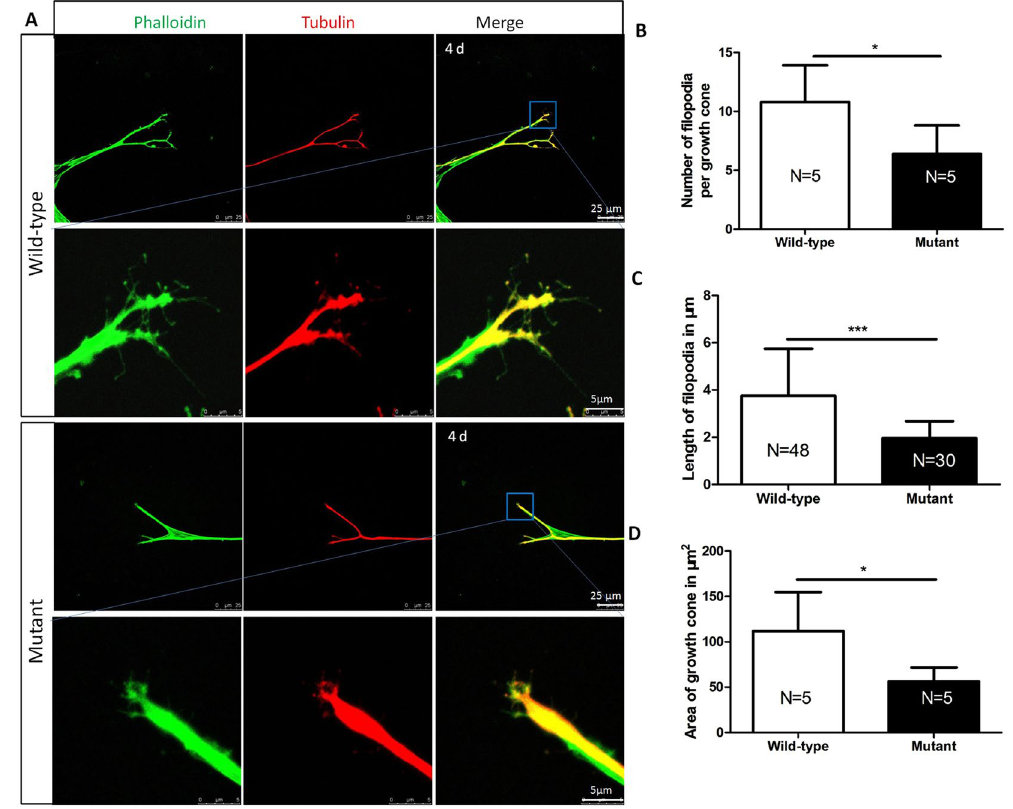
Figure 6. SPAG6 deficiency impairs the growth of growth cones ( A ) Morphology of the SGNs growth cone of Spag6 mutant and wild-type mice. Phalloidin, green; β -tubulin, red. ( B ) Quantification of the average number of filopodia per growth cone (wild-type, 10.80 ± 3.114, N = 5; 6.400 ± 2.408 N = 5; * P < 0.05). ( C ) Quantification of the average length of filopodia from the edge of the growth cone to tips of each filopodia (wild-type, 3.741 ± 2.000, N = 48; 1.964 ± 0.720, N = 30; “N” indicates the number of growth cones; *** P < 0.001). D. Quantification of the average area per growth cone (wild-type, 111.9 ± 42.88, N = 5; mutant, 56.63 ± 15.19, N = 5; * P < 0.05). Comparisons between two groups were tested by Student’s